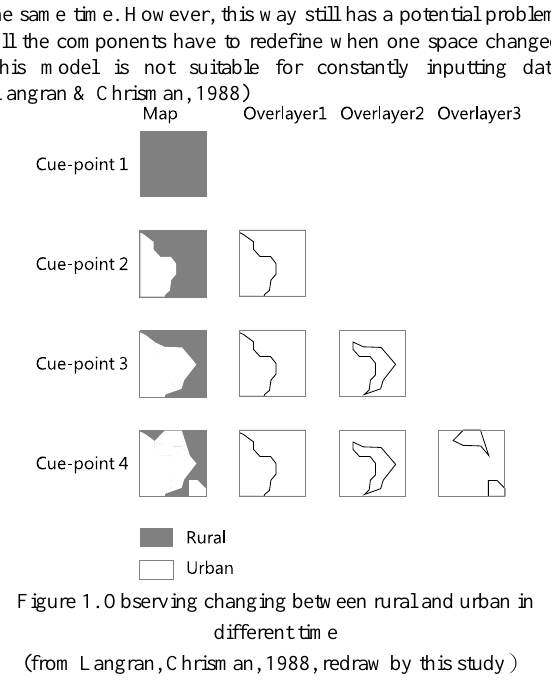
Figure 1. Observing changing between rural and urban in different time